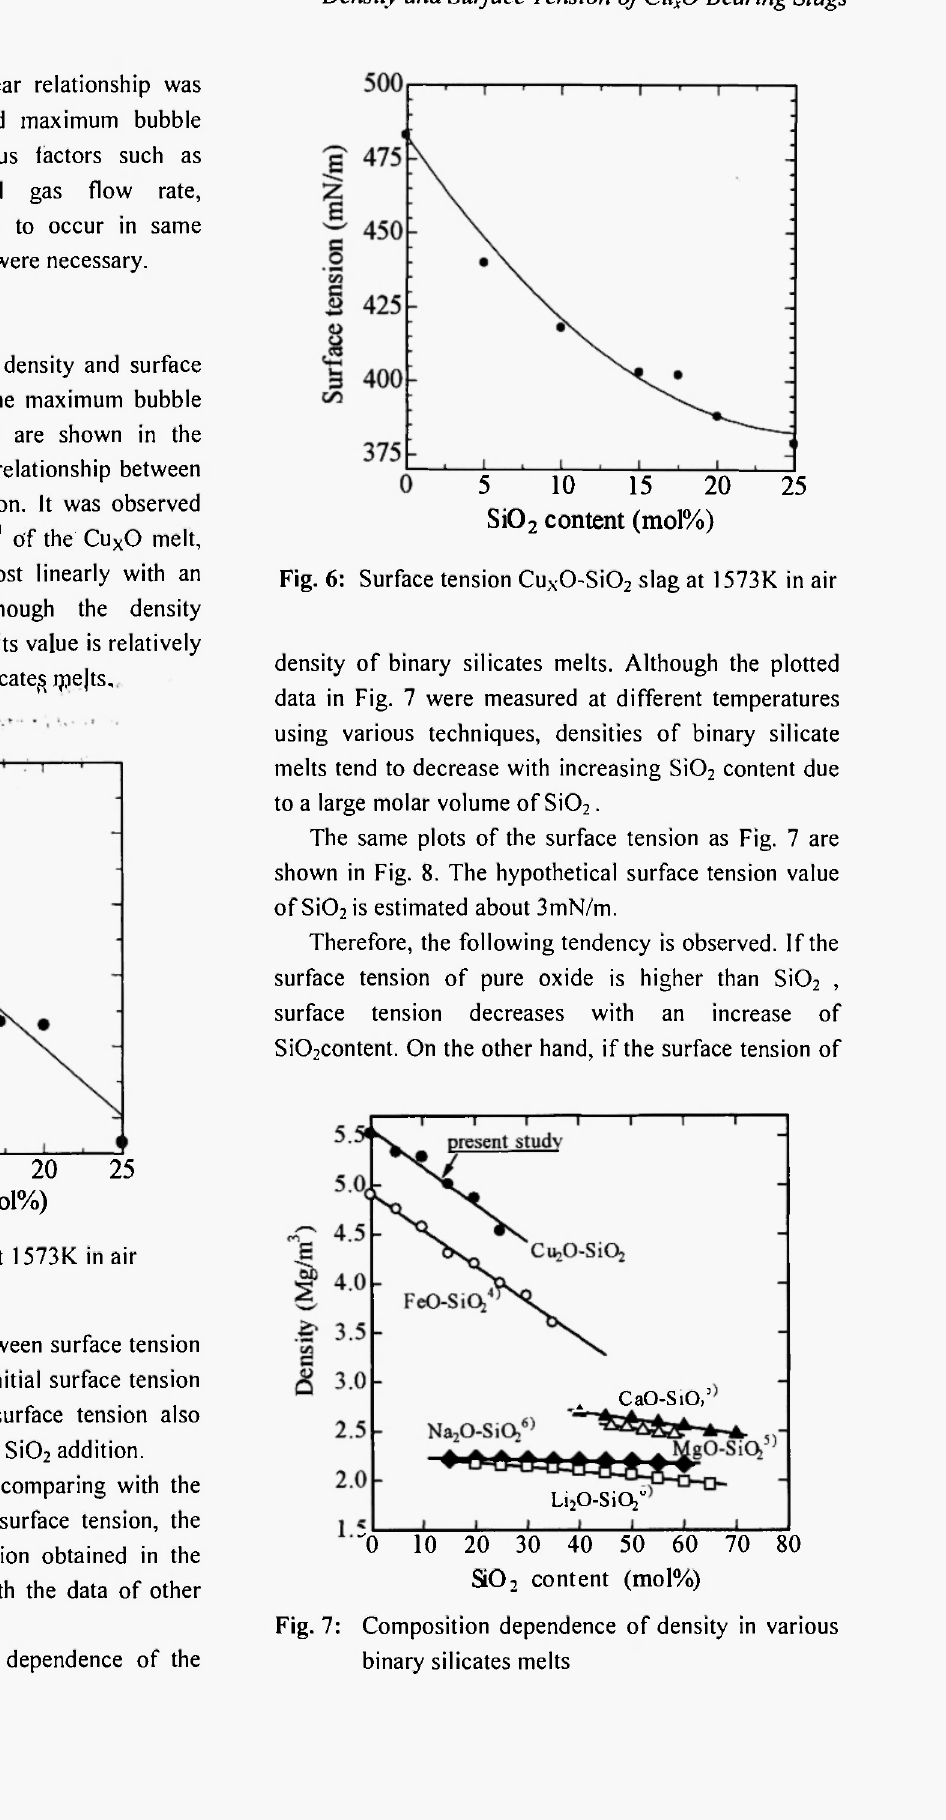
Fig. 7: Composition dependence of density in